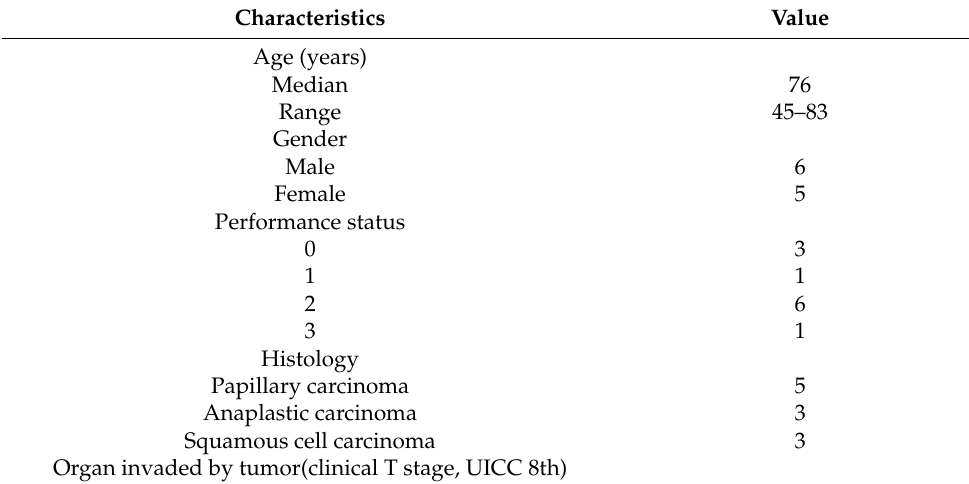
Table 1. Patient and tumor characteristics ( n =